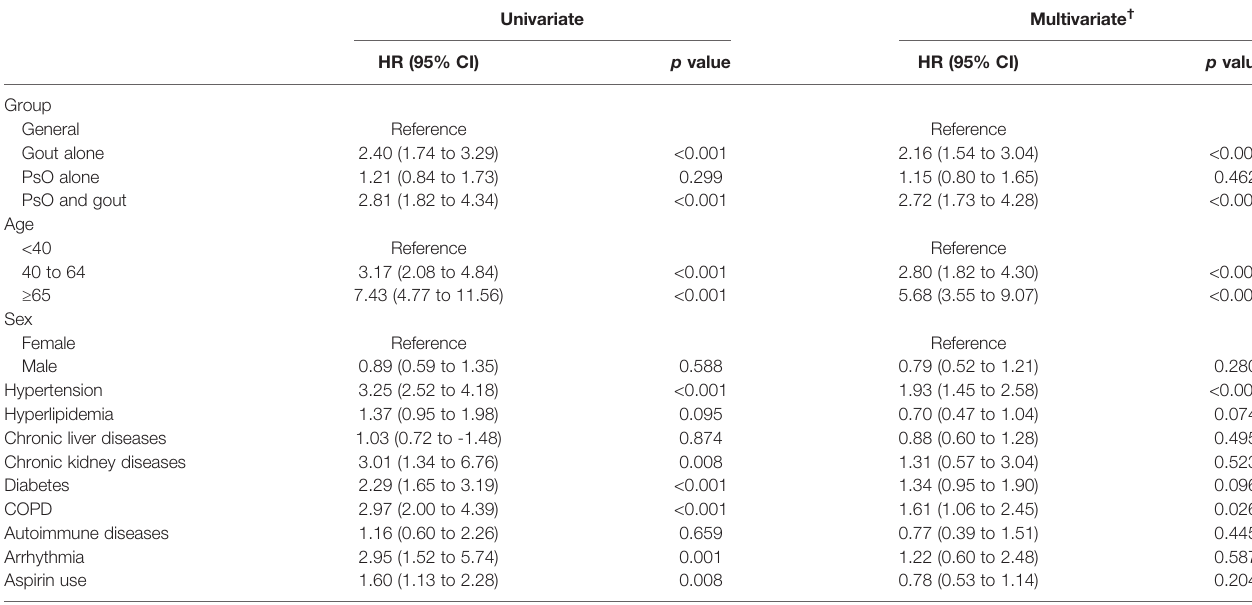
TABLE 3 | Cox proportional hazard model analysis for risk of cardiovascular